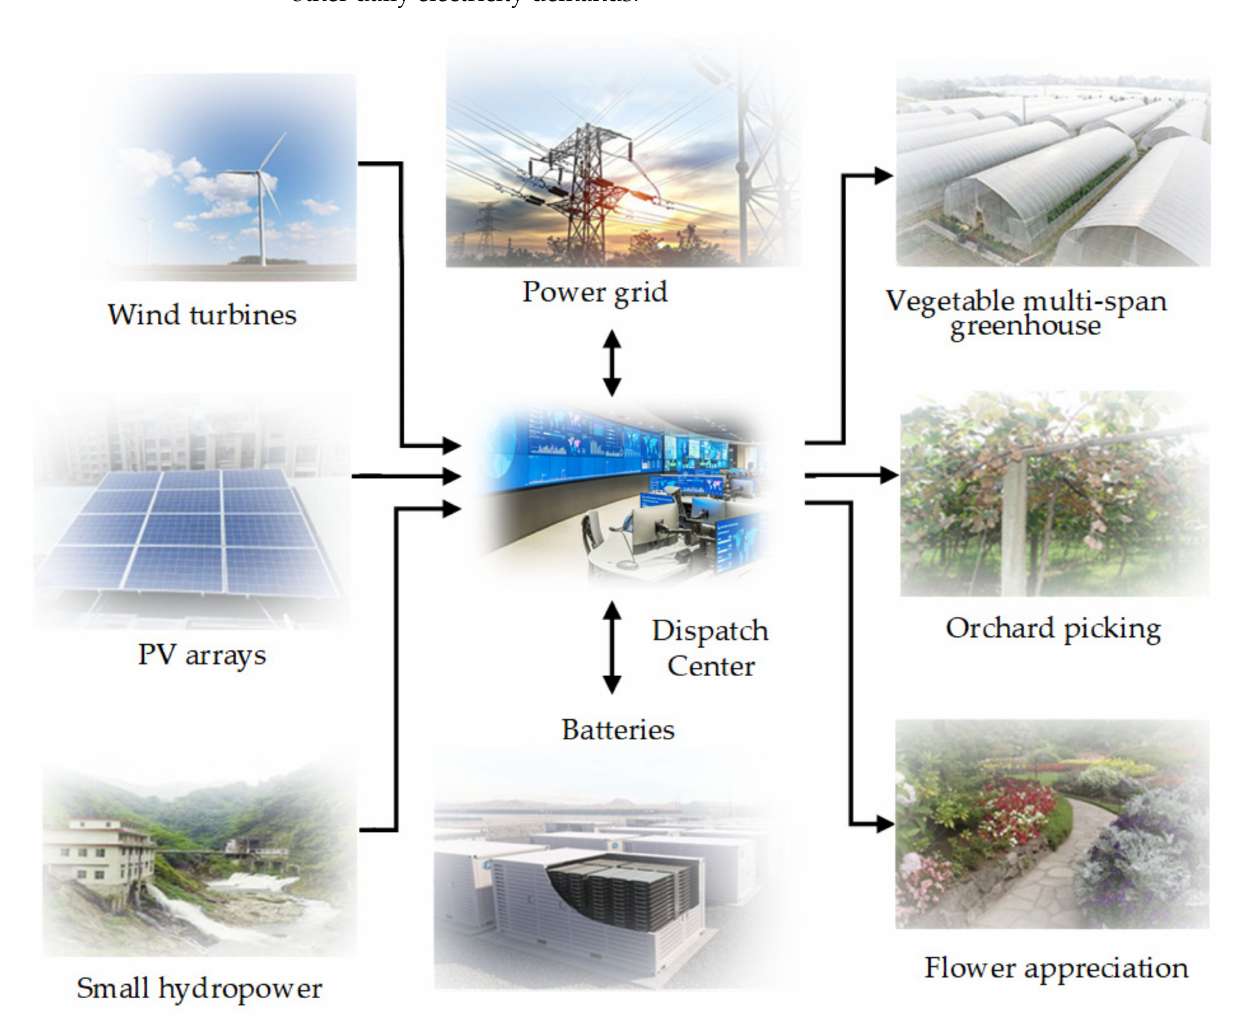
Figure 2. Hybrid wind/PV/small-hydropower/facility-agriculture system based on a